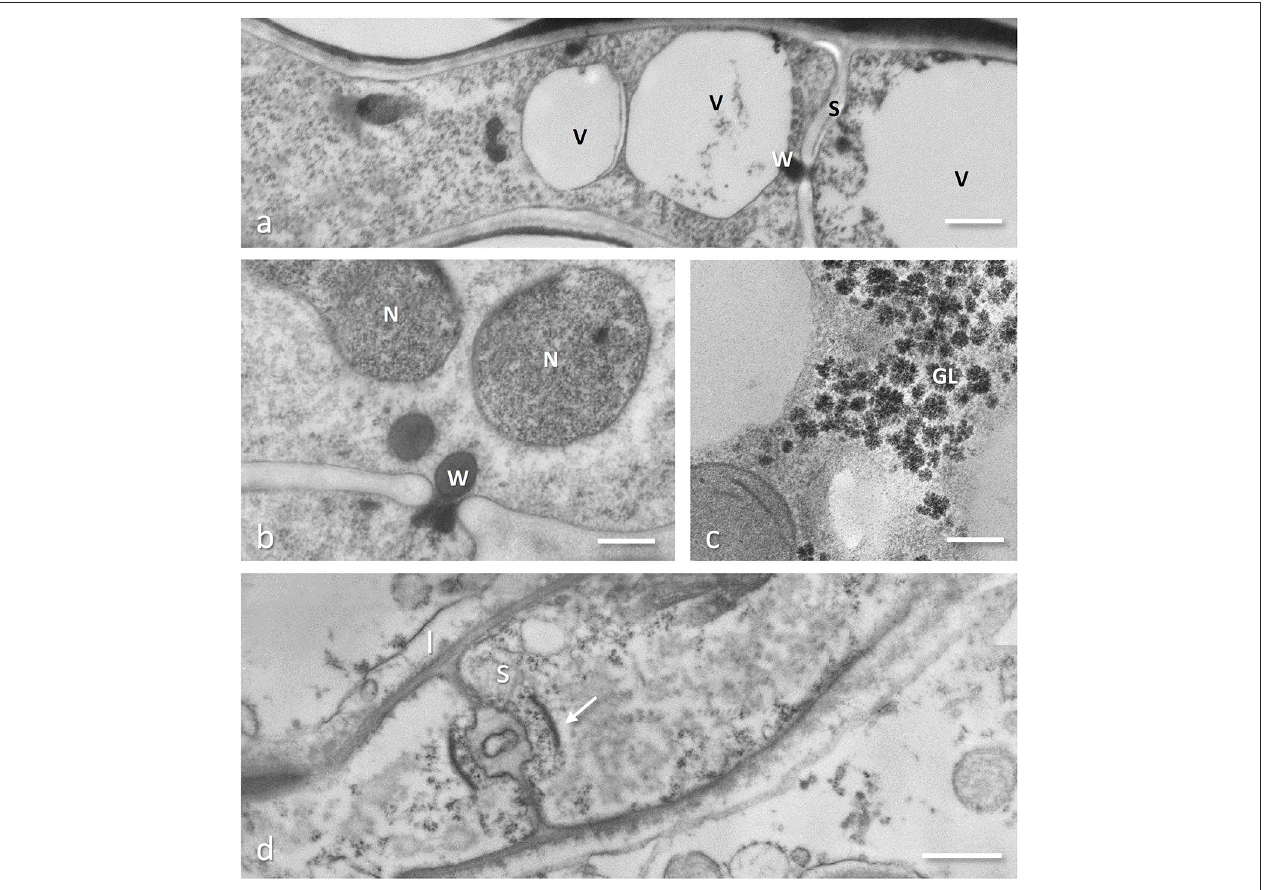
FIGURE 3 | Cryofixed and freeze substituted hyphae ( Tuber melanosporum , a,b ; Gigaspora margarita , c ) and conventionally chemical fixed ( Rhizoctonia -like mycorrhizal fungus, d ). (a) An old part of the hyphae showing two cells, separated by a septum (S) with the central pore plugged by a Woronin body; the cell on the left has two possibly melting vacuoles (V) while the one on the right show a single large vacuole occupying the whole cell lumen. Bar = 0.5 µ m. (b) The septum pore plugged with a Woronin body, besides avoiding loss of protoplasm through the damaged part of the hyphae, can also impair migration of nuclei (N) between adjacent cells. Bar = 0.2 µ m. (c) Glycogen (GL) deposits in an intracellular hypha of the arbuscular mycorrhizal fungus Gigaspora margarita , showing the typical aggregation of the single granules (preparation described in Balestrini et al., 1996a). Bar = 0.2 µ m. (d) Rhizoctonia-like mycorrhizal orchid fungus showing a dolipore septum (S) typical of Basidiomycota surrounded by a flattened and imperforated parenthosome (arrow) characteristic of these orchid mycorrhizal species; the interfacial compartment bounded by the plant plasma membrane is also visible (I). Bar = 1.5 µ